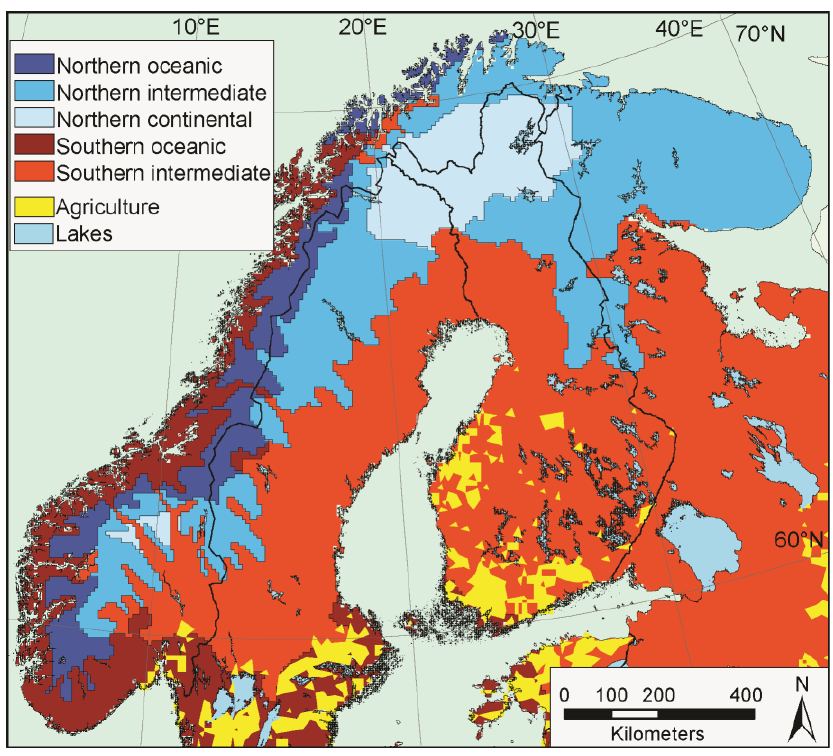
Figure 1. Vegetation regions in the study area. The five regions are reclassified, combined, simplified and redrawn from the Vegetation Zone Map and Vegetation Section Map consisting of 30 regions published by Moen